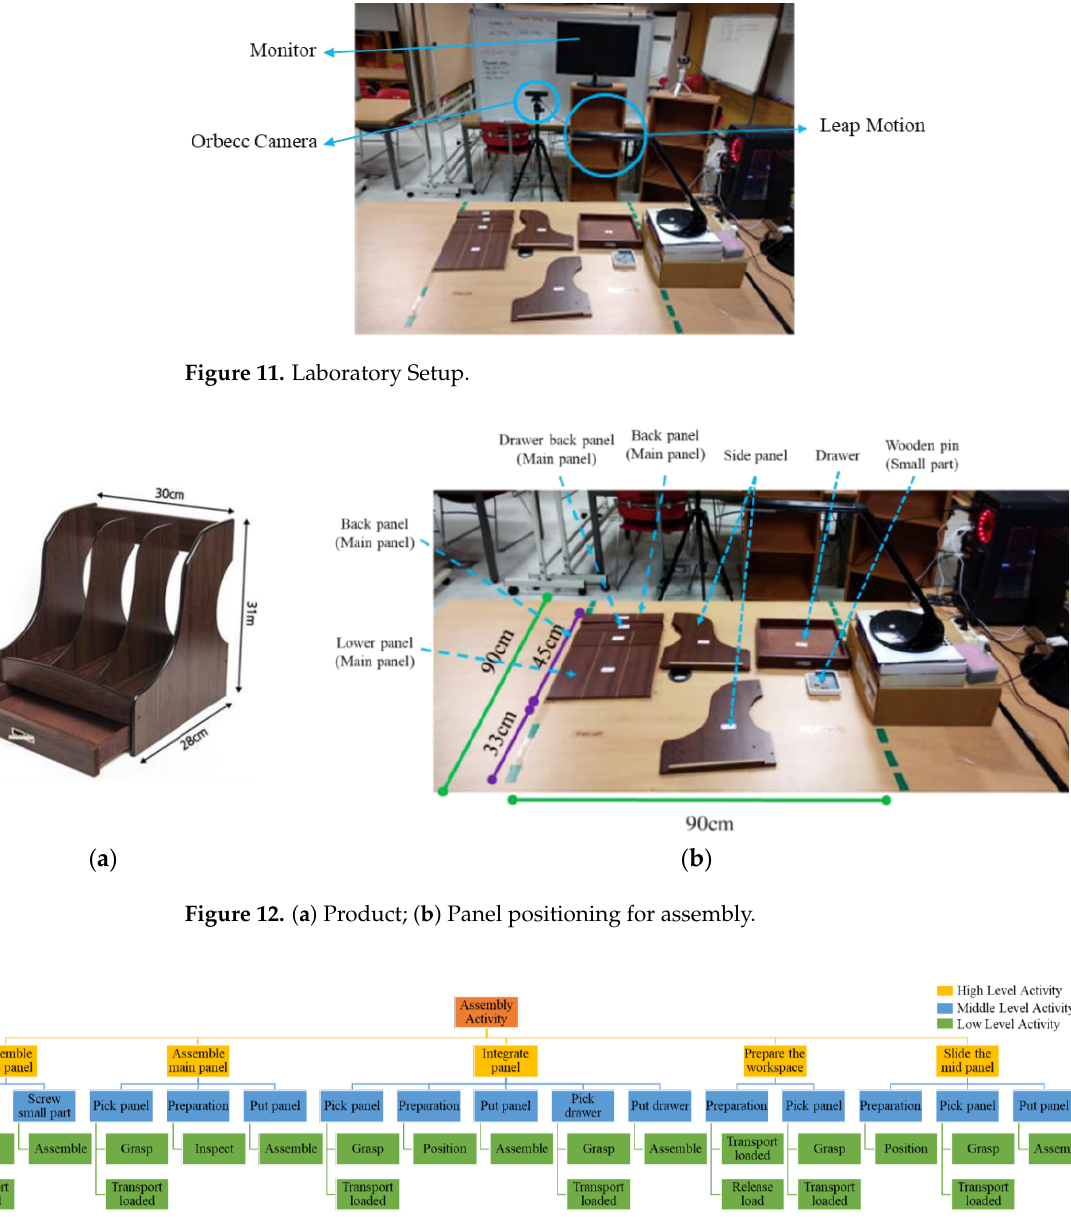
Figure 13. List of Assembly Activity.